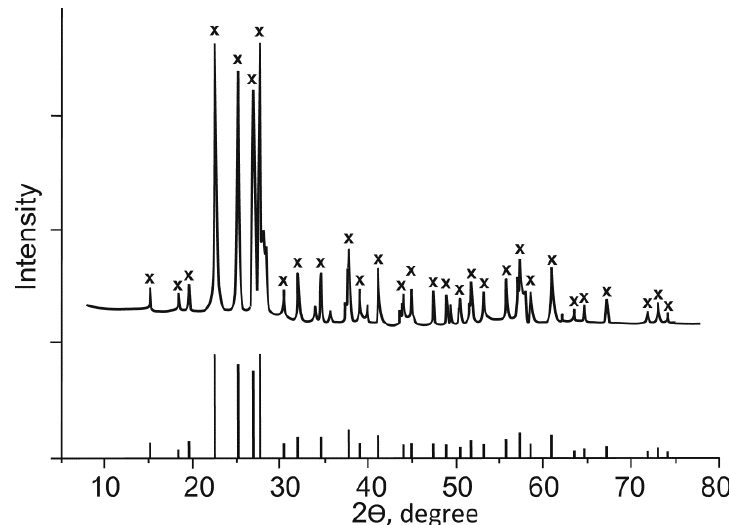
Figure 2. X-ray diffraction (XRD) powder patterns of the product calcined at 750 °С ( x refers to the Ti 2 O(PO 4 ) 2 according to card PDF number 36-0699 [24]). According to The thermogravimetric curve of titanium phosphate (Figure 3), weight losses ◦ ◦ of 16.67% and 4.28% were observed in The regions of 25–125 C and 125–280 C, respectively. A ◦ broad endothermic peak occurred at 124.6 C due to The removal of adsorbed and coordinated ◦ water molecules. In The temperature range of 125–280 C, two concurrent processes took place: ◦ The condensation of hydroxo- and hydrogen phosphate groups [25]. Above 280 C, The mass loss ◦ was 4.21%. No mass loss was observed at temperatures above 700 C, and an exothermic peak was ◦ observed at 722 C corresponding to The titanium phosphate transformation into The Ti 2 O(PO 4 ) 2 phase according to The thermolysis process [18].